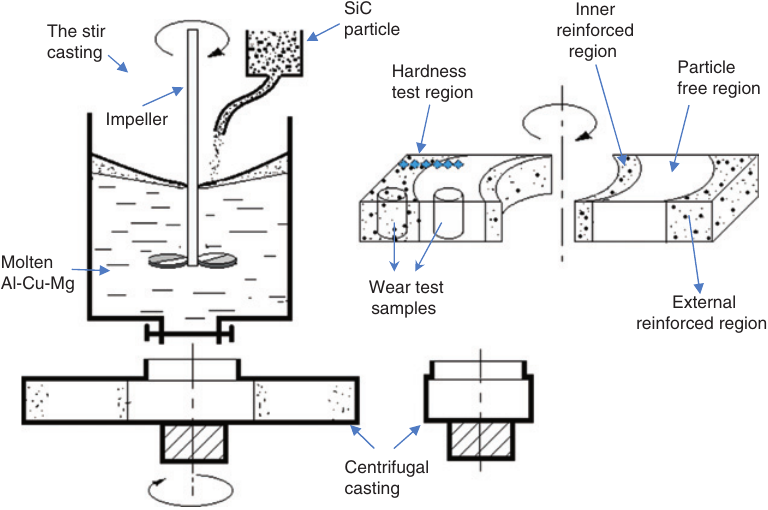
Figure 2 Schematic illustration of the SiC/Al-Cu-Mg composites’ production